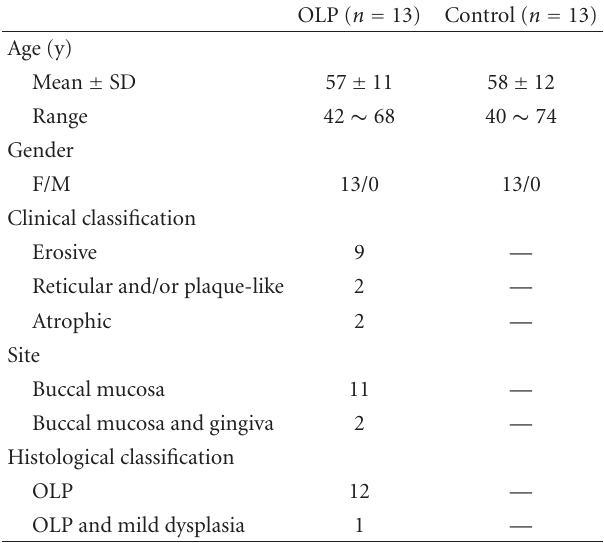
Table 1: Clinical features of